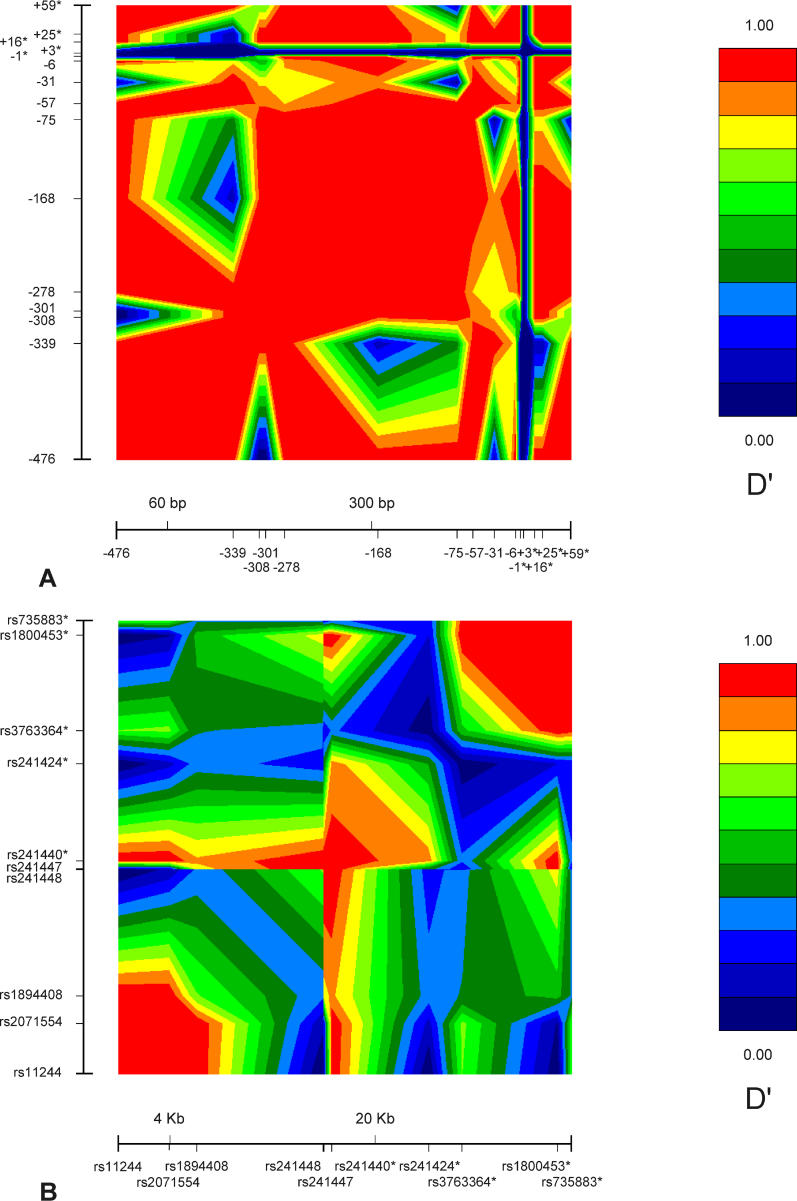
GOLD Plots Showing the Pair-Wise Intermarker LD in Terms of D′(A) shows the LD for 15 SNP markers within the proximal promoter region of human pituitary expressed growth hormone (GH1), and (B) shows the LD for ten SNP markers within the TAP2 gene. In (A), the SNP markers are listed as their position relative to the transcription start site of the GH1 gene whereas in (B), the SNP markers are listed by their National Center for Biotechnology Information (NCBI) reference SNP (rs) numbers. Physical distances are provided. All SNP markers displayed were included in the type I error study whereas only the SNP markers accompanied by an asterisk (*) were included in the power study.